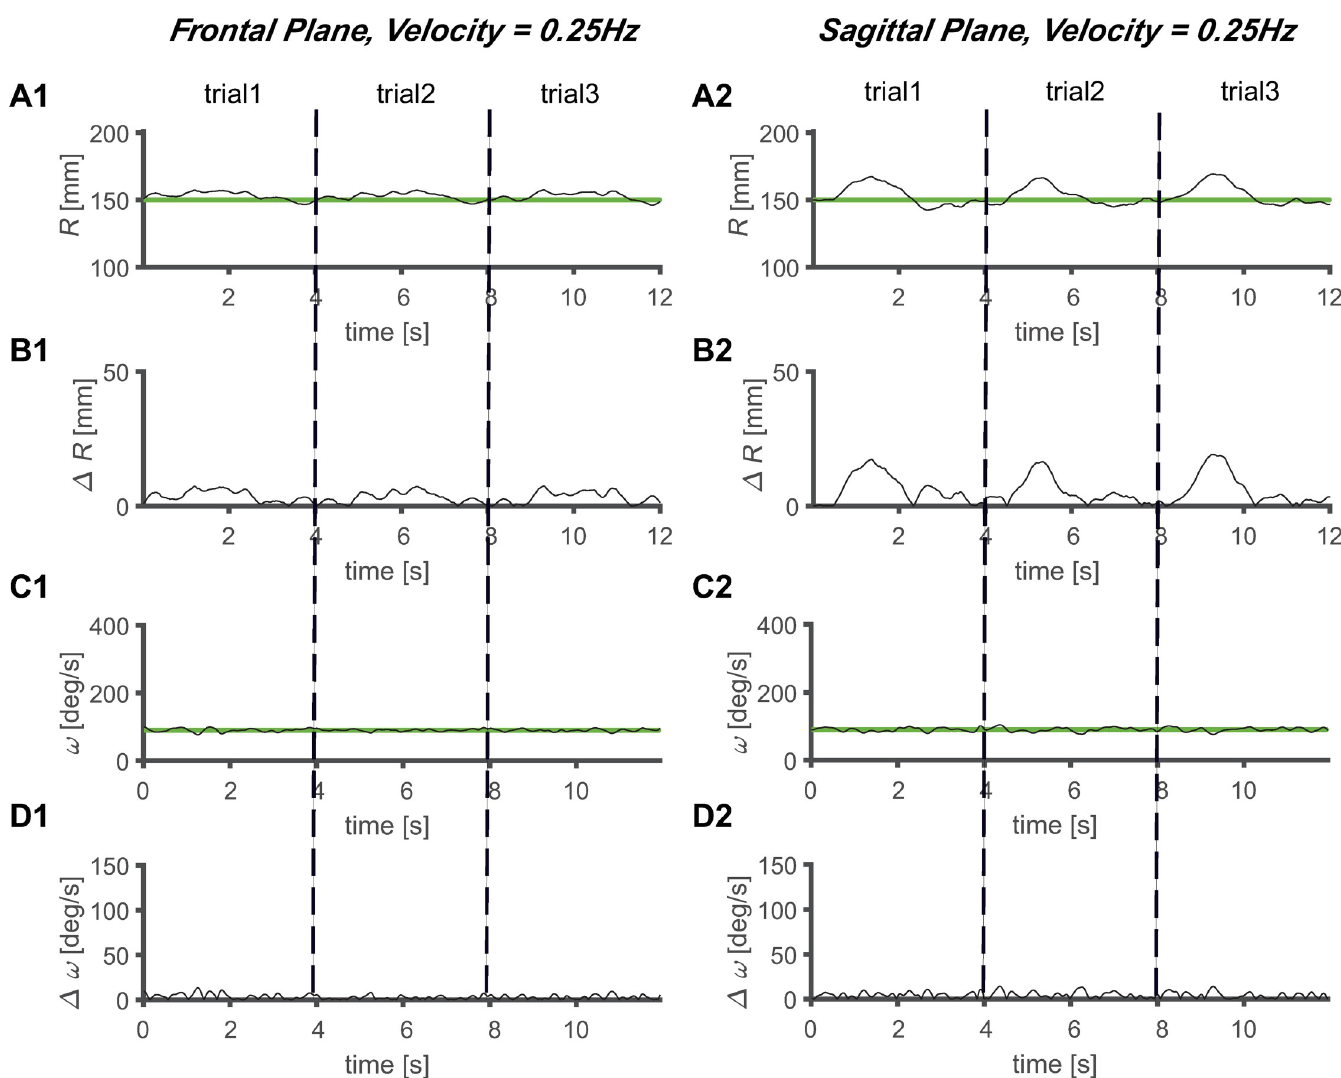
Fig 6. Average circular tracking movement at 0.25 Hz. R value for three trials on the (A1) frontal plane (A1) and (A2) sagittal plane. Absolute value of Δ R on the (B1) frontal plane (B1) and (B2) sagittal plane. ω value for three trials on the (C1) frontal plane (C1) and (C2) sagittal plane. Absolute value of Δ ω on the (D1) frontal plane (D1) and (D2) sagittal